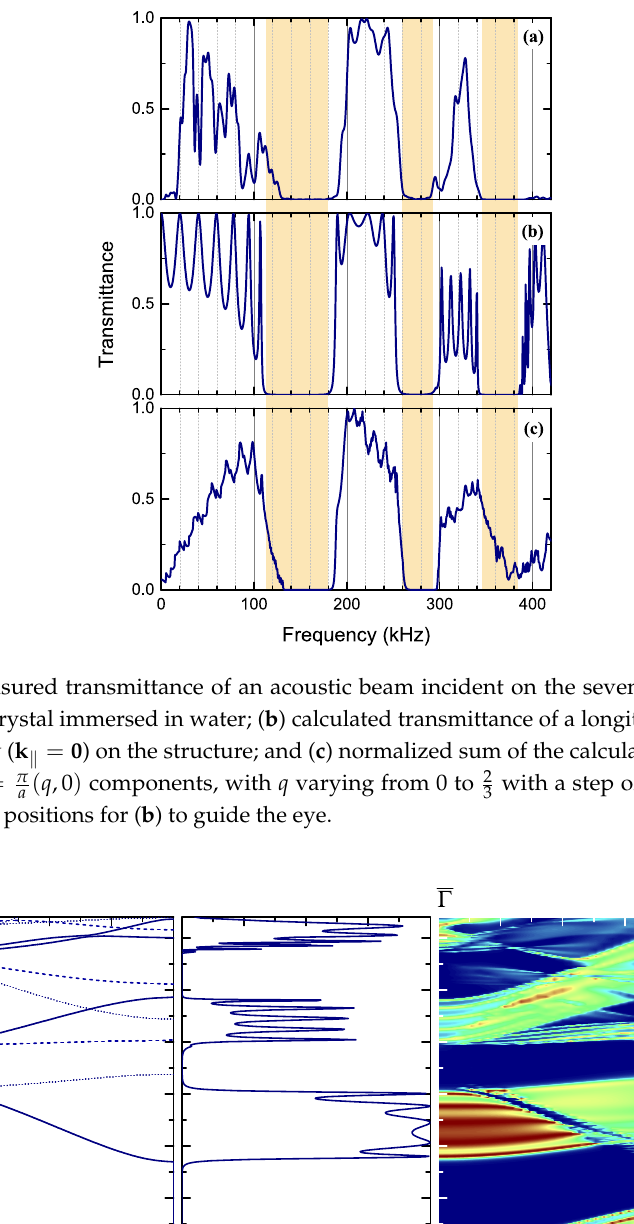
Figure 3. ( a ) calculated frequency band structure for the 3D cubic crystal of touching D5N35 spheres (lattice parameter a = d = 5 mm), immersed in water, along the direction [001] ( k (cid:107) = 0 ). Solid, dotted and dashed lines denote, respectively, active non-degenerate bands (symmetry ∆ 1 ), inactive non-degenerate bands (symmetry ∆ 1 (cid:48) , ∆ 2 , ∆ 2 (cid:48) ) and inactive double degenerate bands (symmetry ∆ 5 ); ( b ) the corresponding transmittance of a longitudinal plane wave incident normally on a seven-(001)-layers thick slab of the crystal; and ( c ) color map of the transmittance spectra along the Γ X direction ( k = ( k x ,0 ) ) of the surface Brillouin zone shown in the (cid:107)